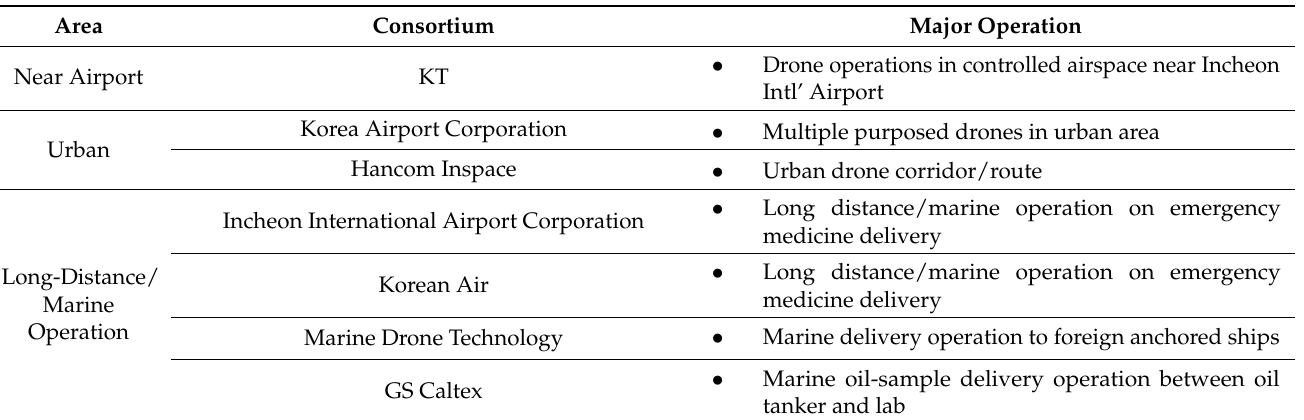
Table 7. 7 operators in 2021 K-Drone Demonstration